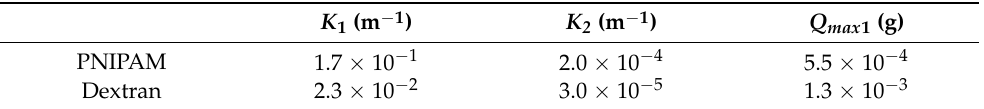
Table 3. Calculated parameters to silica-deposited